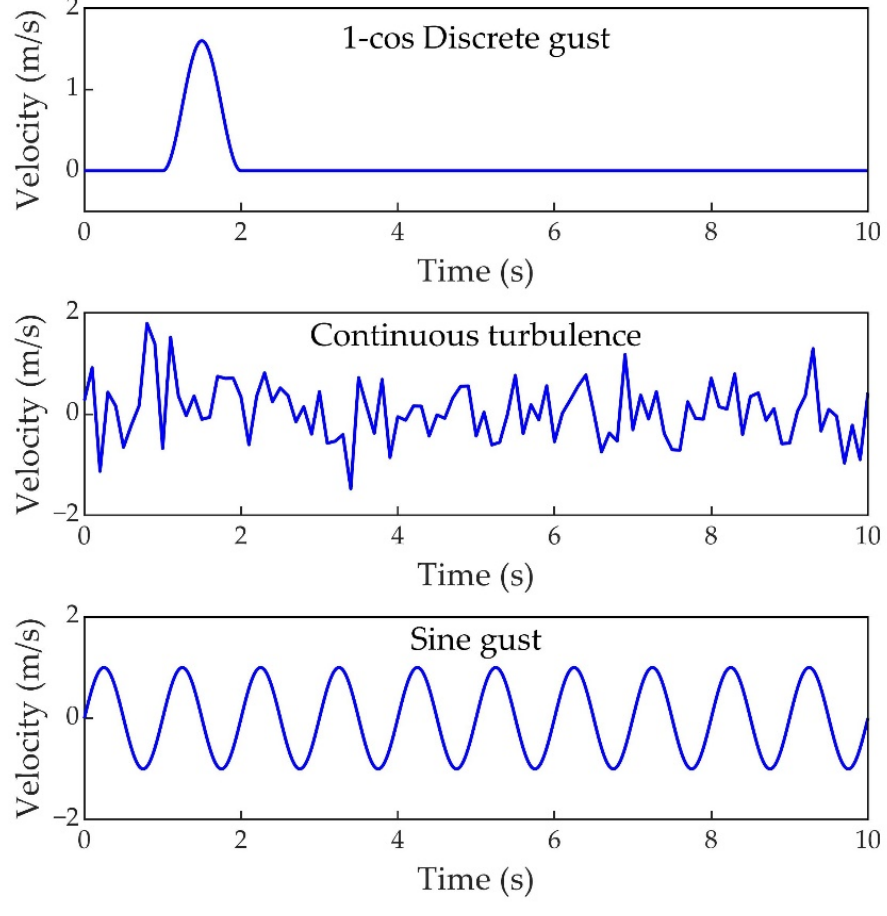
Figure 2. Different types of gusts.